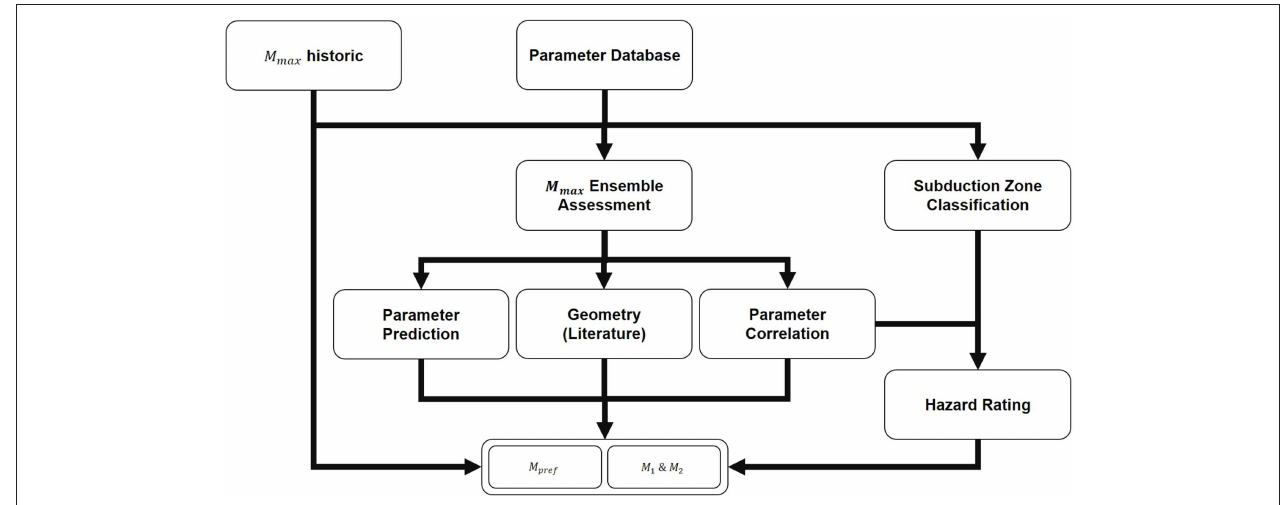
FIGURE 2 | Flow chart of the ensemble approach to determine M max